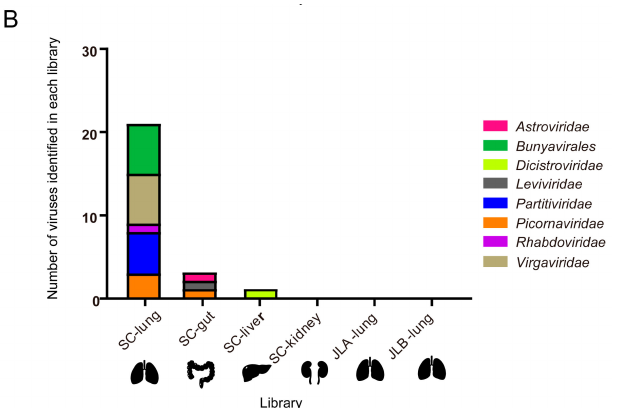
Figure 1. Relative abundance of normalized reads mapping to virus order/families and overview of the RNA viruses identified in each library. ( A ) Relative abundance of normalized viral reads mapping to the viral scaffolds of each virus order/families within each library, falling across nine viral order/families. The smallest reads in each virus order/family are defined as 0%, and the largest reads are defined as 100%; the result of the normalized reads is presented as a percentage. ( B ) Distribution of the number of viruses in each library.